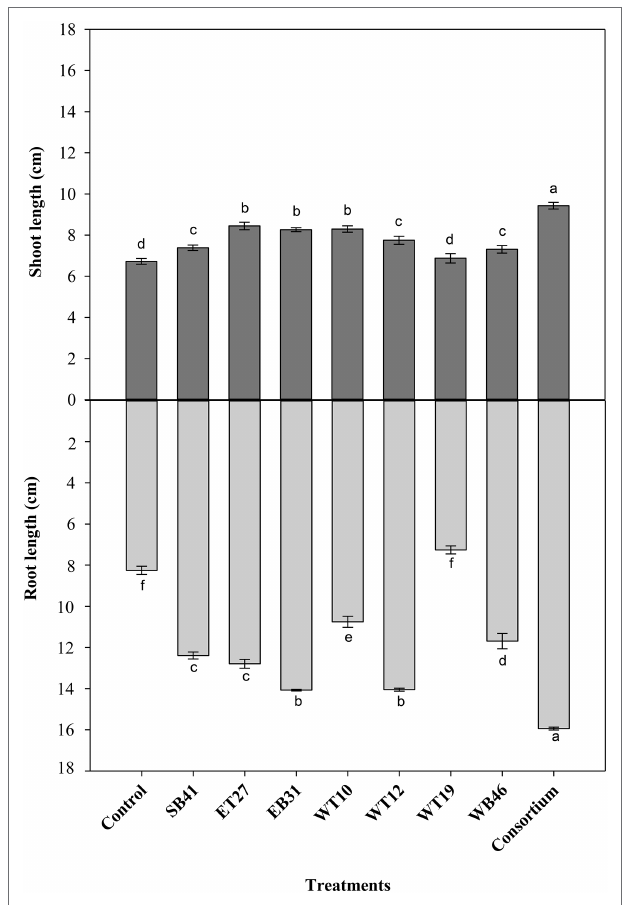
FIGURE 3 | Effect of selected PGPR bacterial strains on root and shoot length (cm) of canola plants measured after 7 days of growth in the presence of 0% n -hexadecane. Error bars represent SDs, and different letters indicate significance according to Tukey’s post-hoc test at p ≤